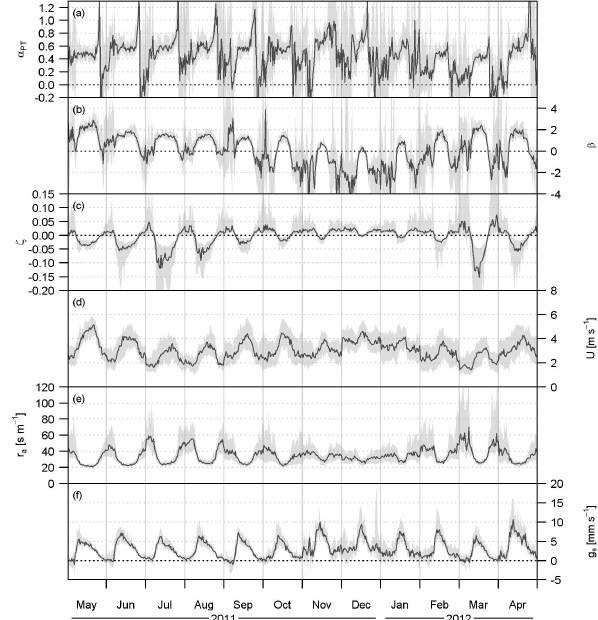
Fig. 9. Monthly median diurnal cycles (lines) and interquartile ranges (shading) of (a) the aridity parameter, α PT ; (b) Bowen ratio, β ; (c) stability parameter, ζ ; (d) wind speed, U ; (e) aerodynamic resistance, r a ; and (f) surface conductance, g s , for all conditions. See text for